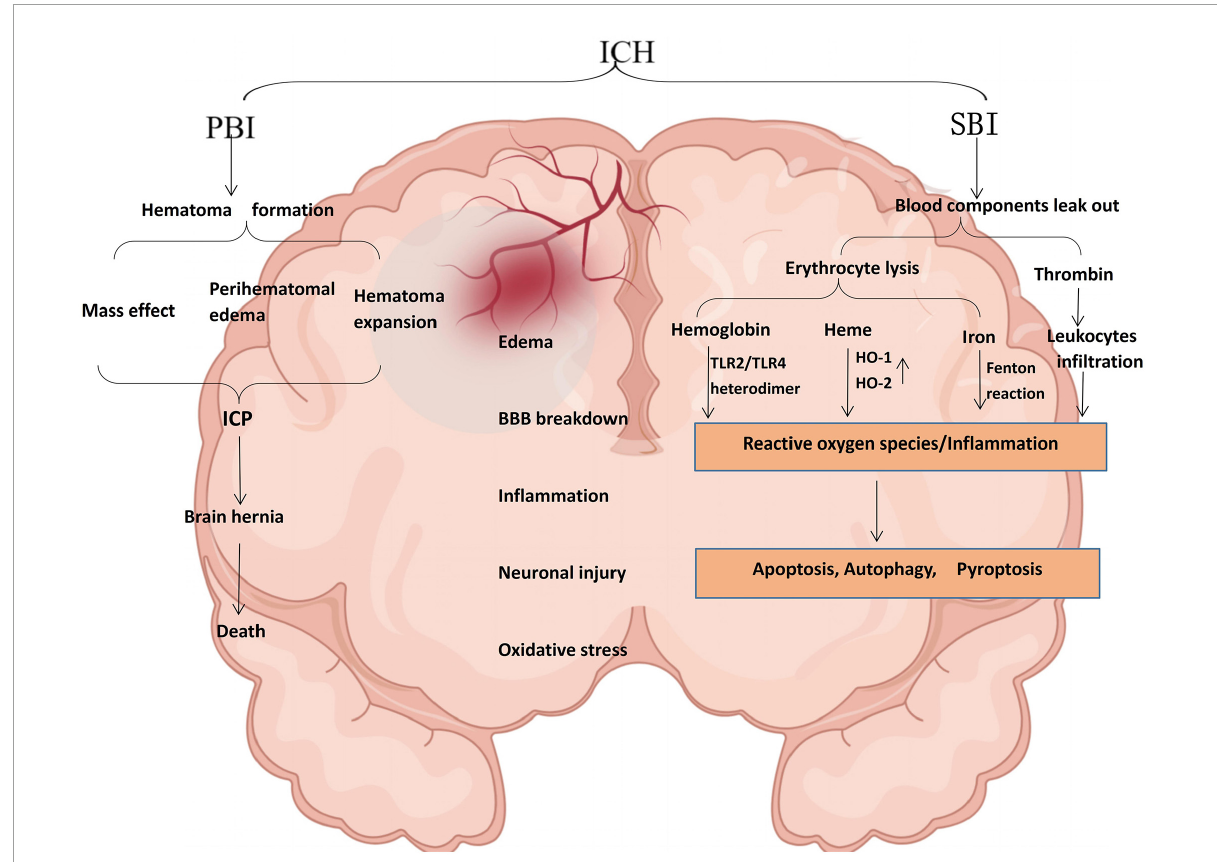
FIGURE1 Schematic illustration of pathophysiology after ICH. PBI and SBI are not performed singly, leading to edema, BBB disruption, inflammation, neuronal damage, and oxidative stress. Thrombin can induce significant neuroinflammation in microglia. Most extravasated erythrocytes are trapped in the hematoma and phagocytosed or lysed by microglia/macrophages. In ICH, hemoglobin is a key factor in the inflammation of damaged erythrocyte leakage and is a potent activator of inflammation. Hemoglobin induces proinflammatory cytokine production in microglia through TLR2/TLR4 heterodimer. Heme is partially degraded by HO-1 in macrophages/microglia or HO-2 in neurons to form ferrous iron, carbon monoxide, and biliverdin. The released iron can produce a large amount of ROS through the Fenton reaction and cause oxidative stress damage to nearby tissues. TLR2/TLR4, toll-like receptor 2/4; HO-1, heme-oxygenase-1; ROS, reactive oxygen species (by